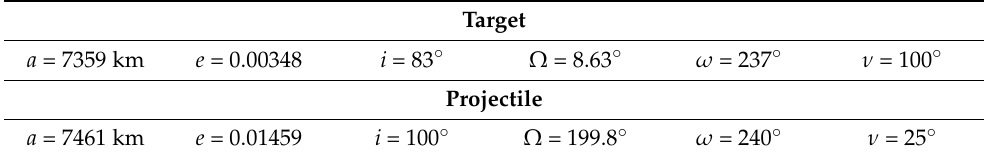
Table 2. Orbit parameters of parents. Target a = 7359 km e = 0.00348 i = 83 ◦ Ω = 8.63 ◦ ω = 237 ◦ ν = 100 ◦ Projectile a = 7461 km e = 0.01459 i = 100 ◦ Ω = 199.8 ◦ ω = 240 ◦ ν = 25 ◦